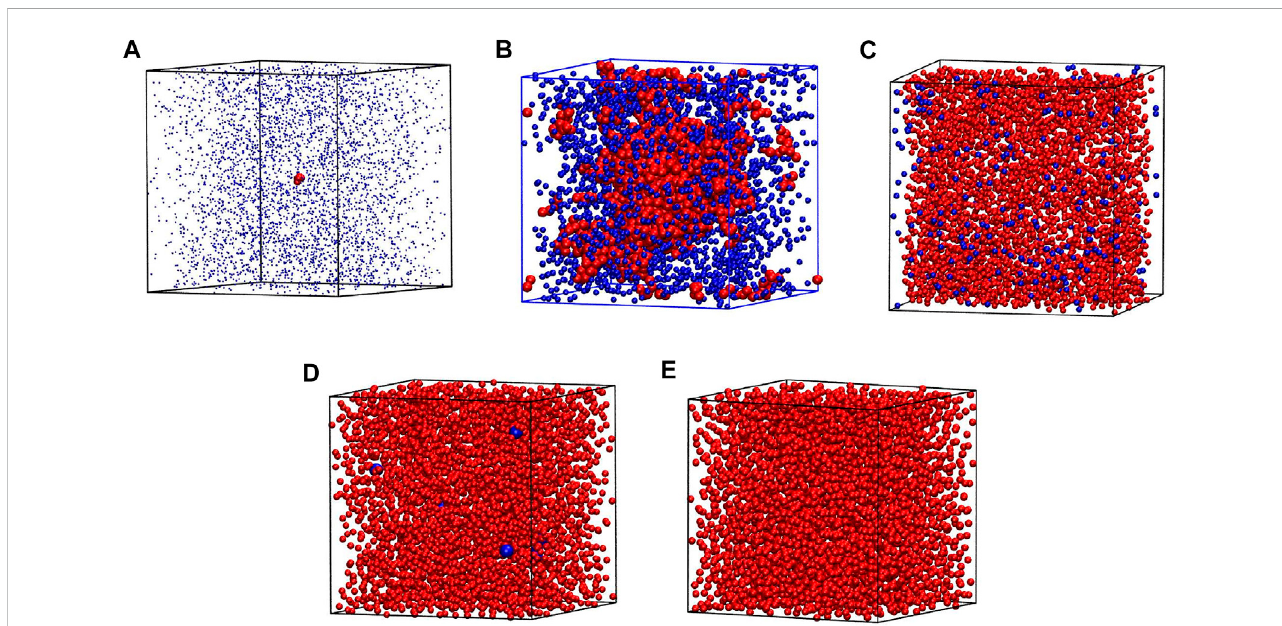
FIGURE 5 The phase separation during the density changes at T *=1.1 for system composed of 4,000 atoms. The densities of each box are ρ *=0.01, 0.11, 0.35, 0.57and0.8for boxes (A) , (B) , (C) , (D) ,and (E) ,respectively. Theclustersare markedbyredinpanels (A,B) .At thedensephase (C,D) theclusters aremarkedby blue. The positions on the phase diagram of particular cases are marked by green letters in Figure